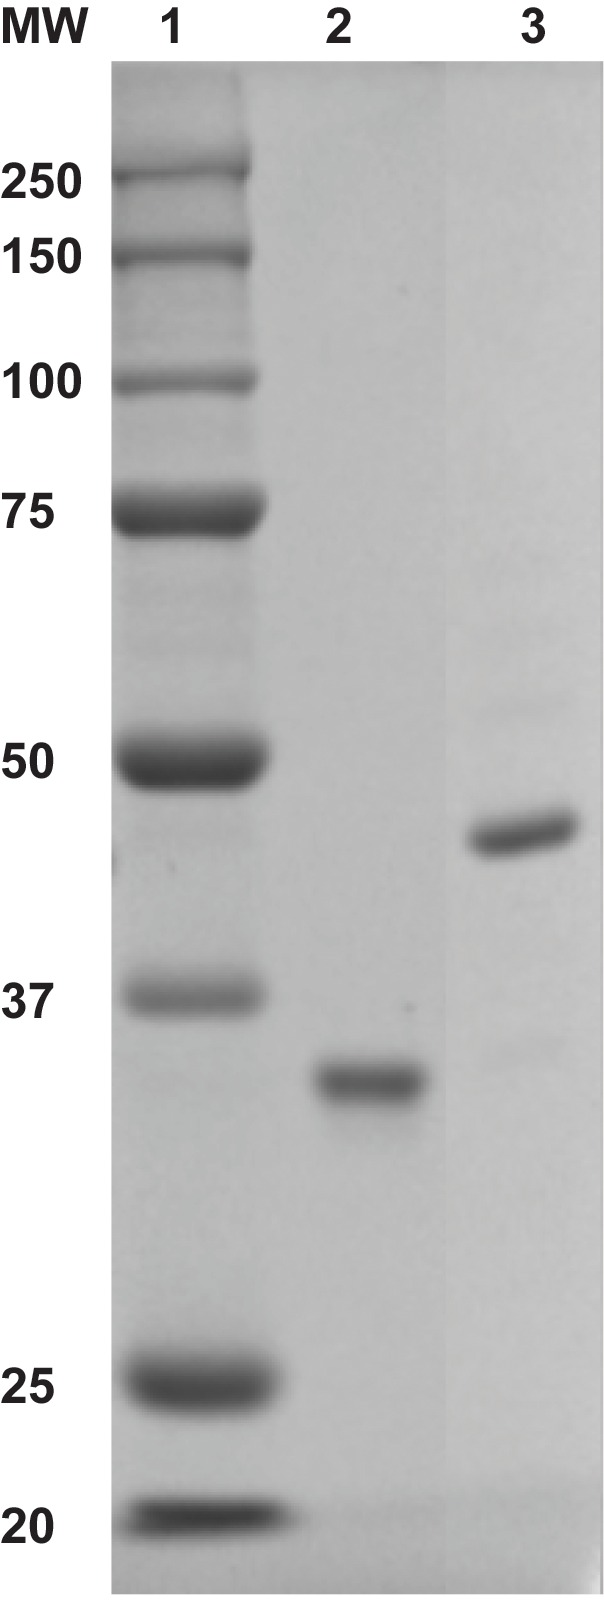
Monoubiquitinated PCNA contains a single ubiquitin moiety on K164 of each monomer within a homotrimeric clamp ring.(Ub)3-PCNA (10 pmol monomer, Lane 3) was analyzed by coomassie-blue staining after denaturing 12% SDS-PAGE. Lane 1 contains a molecular weight (MW) marker (sizes in kD are indicated on left) and Lane 2 contains wild-type PCNA (10 pmol monomer). The molecular weight of PCNA (Lane 2) is increased approximately 8.5 kDa by the attachment of a single ubiquitin moiety.